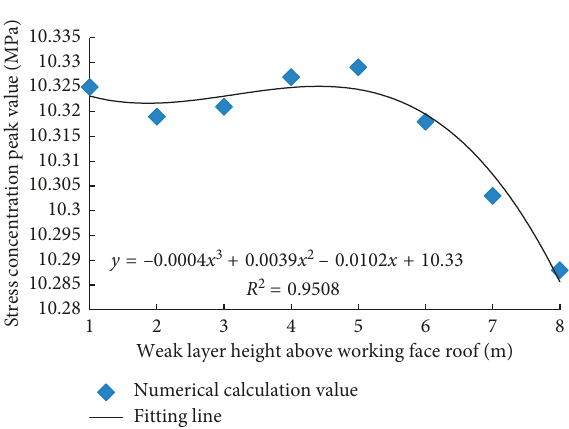
Figure 6: Statistical analysis of peak intensity.